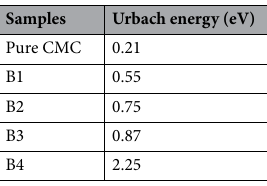
Table 6. Urbach energy of pure CMC and CMC with different concentrations of CuO-NPs (2, 4, 6 and 8wt.%).